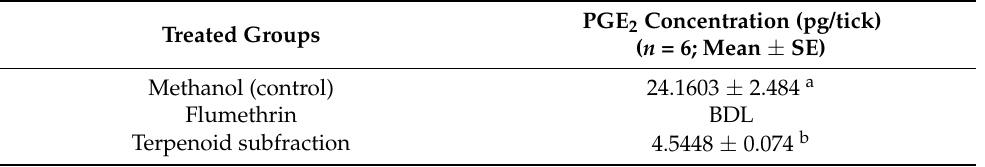
Table 3. Mean concentration of PGE 2 detected in the ovaries of ticks treated with methanol, flumethrin and terpenoid subfraction of hexane fraction of ethanolic extract of A. nilagirica . PGE 2 Concentration (pg/tick) Treated Groups ( n = 6; Mean ± SE) Methanol